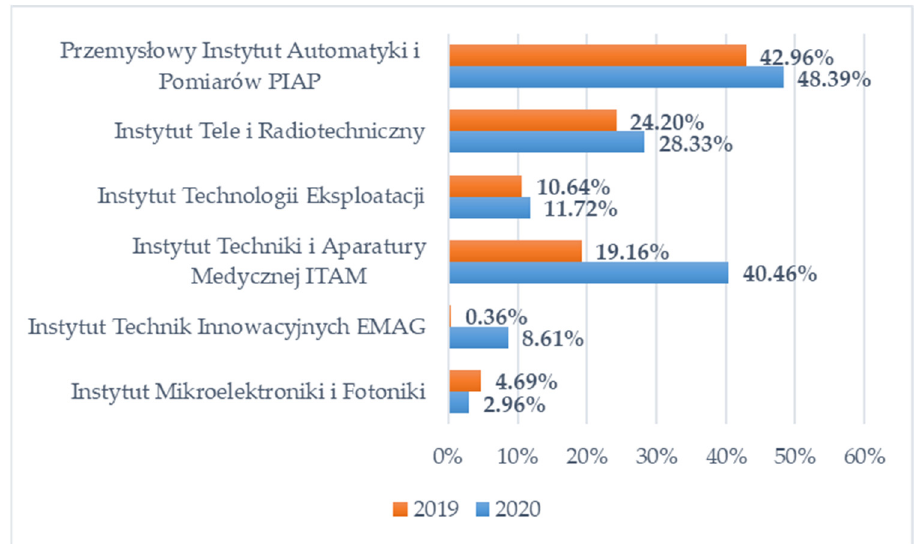
Figure 4. Share of commercialization revenue in total revenue of researched institutes between 2019 and 2020 [in %]. Source: [97].